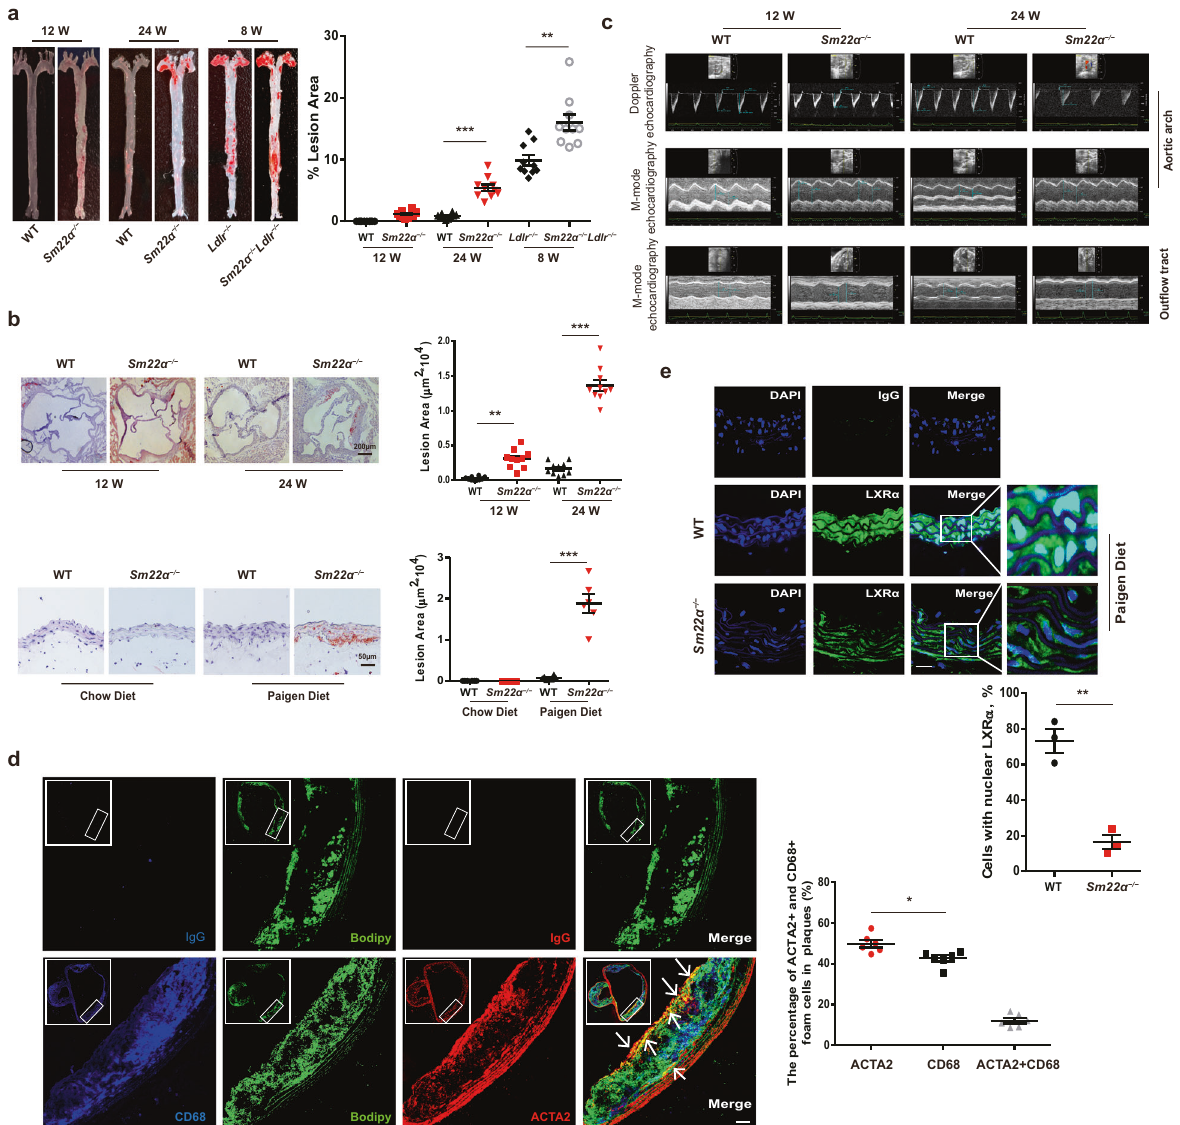
Fig. 1 Impaired SM22 α expression is associated with the development of atherosclerosis. a , b WT ( n = 10) and Sm22 α − / − ( n = 10) mice with or without Ldlr − / − background ( n = 10) fed Paigen diet for 8, 12 and 24 weeks respectively. Representative images of en face ORO-stained aortas ( a ), aortic sinus, aortic cross-sections ( b ) and quanti fi cation of lesion areas are shown. c M-mode and Doppler echocardiography images obtained from the aortic arch and out fl ow tract of WT ( n = 15) and Sm22 α − / − ( n = 15) mice fed Paigen diet for 12 and 24 weeks. A s : out fl ow tract and aortic diameter in systole; A d : out fl ow tract and aortic diameter in diastole. d Identi fi cation of SMC-derived foam cells within atherosclerotic lesion of Sm22 α − / − mice ( n = 6) by CD68 (blue), ACTA2 (red) and Bodipy (green). Scale bar, 20 µm. Arrows indicated foam cells that were VSMCs-derived. e Representative immuno fl uorescence of LXR α (red) and quanti fi cation of cells with nuclear LXR α in the aortic sections from WT ( n = 3) and Sm22 α − / − ( n = 3) mice. Scale bar, 15 µm. Data and images are representative of at least three independent experiments. Data in ( a ) and ( b ) were analyzed by two-way and one-way ANOVA respectively. Data in ( d ) and ( e ) were analyzed by unpaired t test. * p < 0.05; ** p < 0.01; *** p <